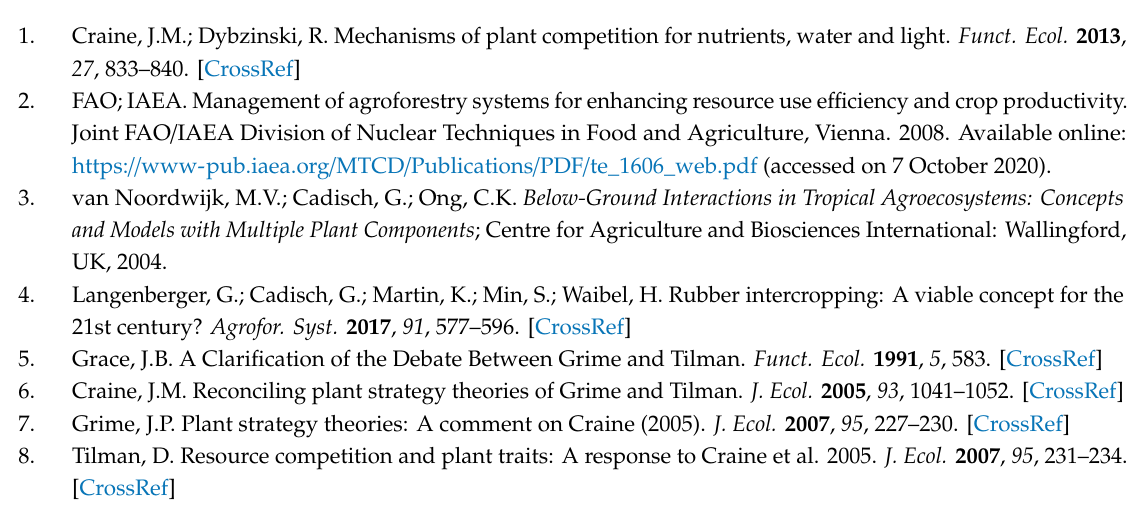
Figure S2: (a) Rubber tapping period, the season, the phenophase of the rubber tree, and the sampling date, (b) sketch maps of the sampling in the AFSs. FS, fruit setting; FR, fruit ripening; DS, dormant stage; LS, leaf shedding; LF, leaf flushing; LE, leaf expansion; FP, flowering phase. Figure S3: C concentration in di ff erent plant organs, litter, and soil in (a) rubber and cocoa, (b) rubber and flemingia, (c) rubber and tea, and (d) rubber and co ff ee AFSs. RM indicates rubber monoculture, which is shown as the red box area in the histograms. R_Leaf, R_Stem, and R_Root represent the leaves, stems, and roots of rubber trees, respectively, while I_Leaf, I_Stem, and I_Root represent the leaves, stems, and roots of the intercrops in each AFS, respectively. Di ff erent lowercase letters in the blue bars of the histograms indicate significant di ff erences among season after post hoc Tukey’s tests ( α = 0.01). The data are expressed as the means ± SDs. Figure S4: N concentrations of di ff erent plant organs, litter, and soil in (a) rubber and cocoa, (b) rubber and flemingia, (c) rubber and tea, and (d) rubber and co ff ee AFSs. See Figure S3 for abbreviations and related descriptions. The data are expressed as the means ± SDs. Figure S5: P concentration of di ff erent plant organs, litter, and soil in (a) rubber and cocoa, (b) rubber and flemingia, (c) rubber and tea, and (d) rubber and co ff ee AFSs. See Figure S3 for abbreviations and related descriptions. The data are expressed as the means ± SDs. Figure S6: Litter C:N and C:P ratios in each AFS. The red box indicates the RM. The bold asterisk marks a significant di ff erence in the C:N and C:P ratios of the litter between the RM and each AFS ( P ≤ 0.01). Figure S7: The correlation network in (a) RM (rubber monoculture), (b) all AFSs, and the (c) rubber and cocoa, (d) rubber and flemingia, (e) rubber and tea, and (f) rubber and co ff ee AFSs. The color of a connecting line indicates the sign of the correlation (blue indicates a positive correlation, and red indicates a negative correlation), and the width indicates the strength of the correlation. All the correlation coe ffi cients reach an extremely significant level ( P < 0.01) and are not less than 0.5. Figure S8: Pearson correlation-based similarity in (a) rubber leaf, (b) rubber stem, (c) rubber root, (d) litter, and (e) soil among the RM (rubber monoculture), COC (rubber and cocoa AFS), FLE (rubber and flemingia AFS), TEA (rubber and tea AFS), and COF (rubber and co ff ee AFS). All the similarities reach a significant level ( P < 0.05). Figure S9: The probability distribution of the N status observed condition. Figure S10: Exposed fine roots of rubber trees above the